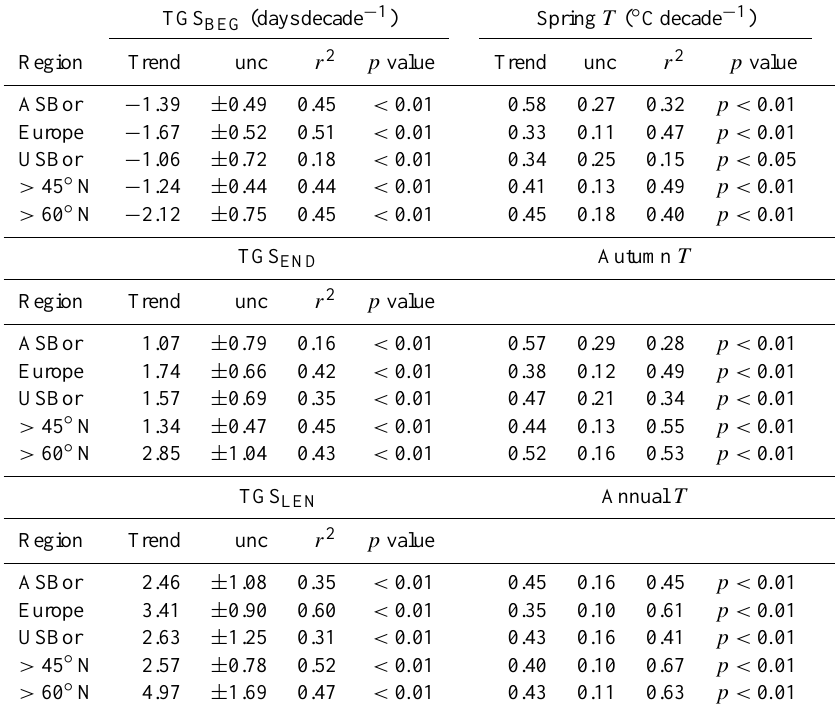
Table E1. Temperature linear trend analysis (1970–2011) for the beginning and end of the thermal growing season.